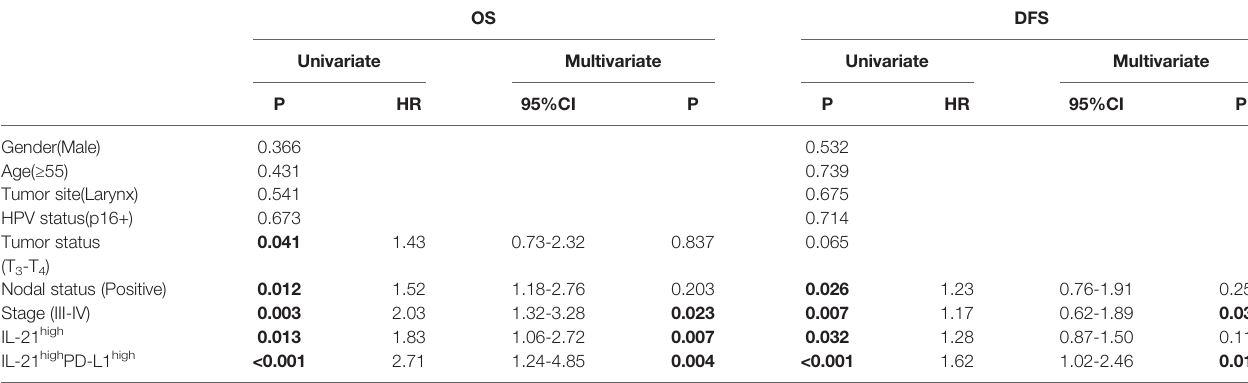
TABLE 3 | Univariate and multivariate analyses of factors associated with survival and recurrence.